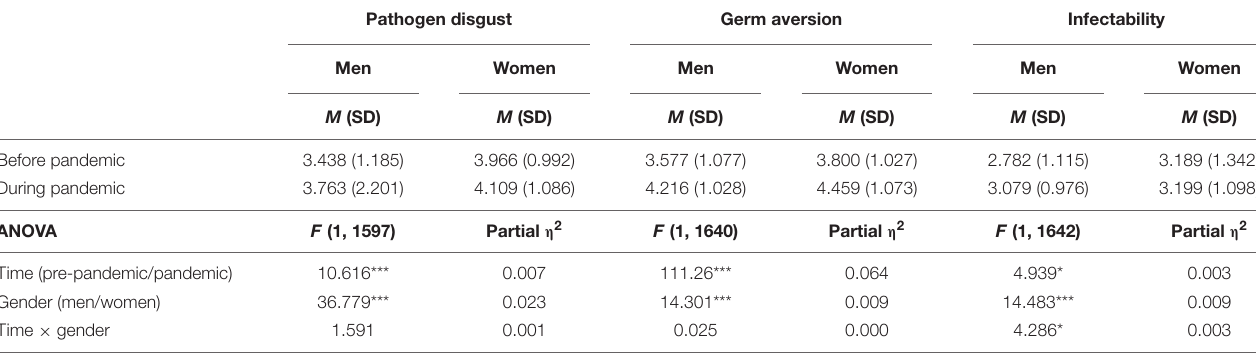
TABLE 4 | BIS-related measures before/during the COVID-19 pandemic. Pathogen disgust Germ aversion Infectability